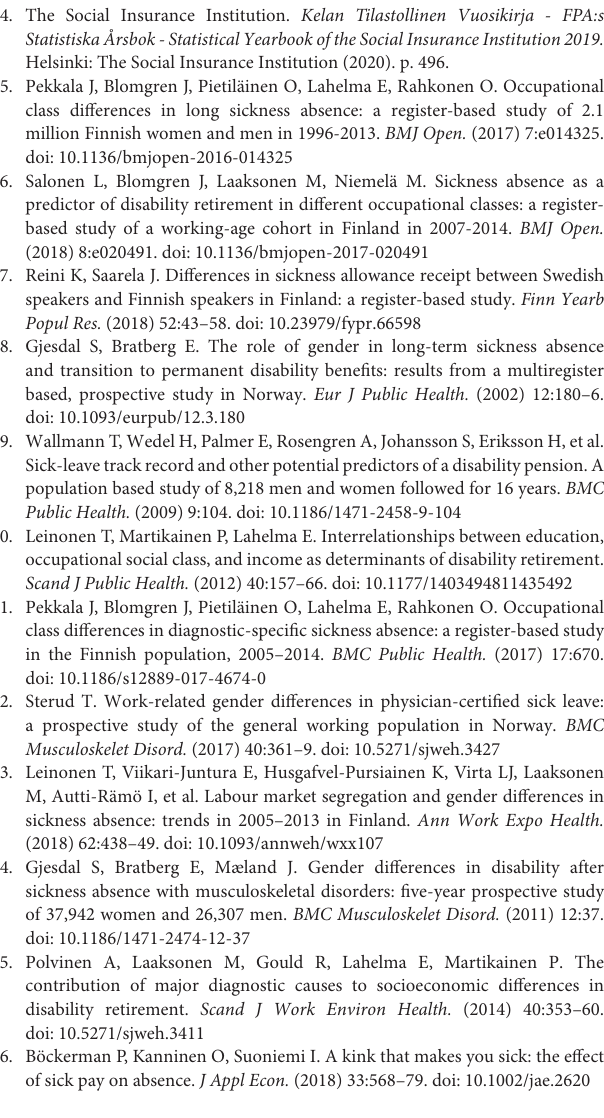
Supplementary Figure 1 | Observation plan. Grey shaded area is the observation window. Supplementary Table 1 | Variables’ distributions by person years and DP rate, by